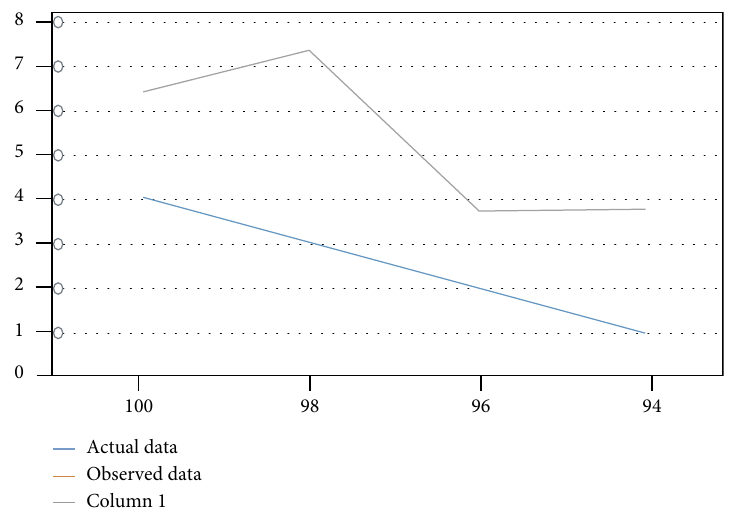
Figure 3: Data collected for measuring the body temperature of patients.